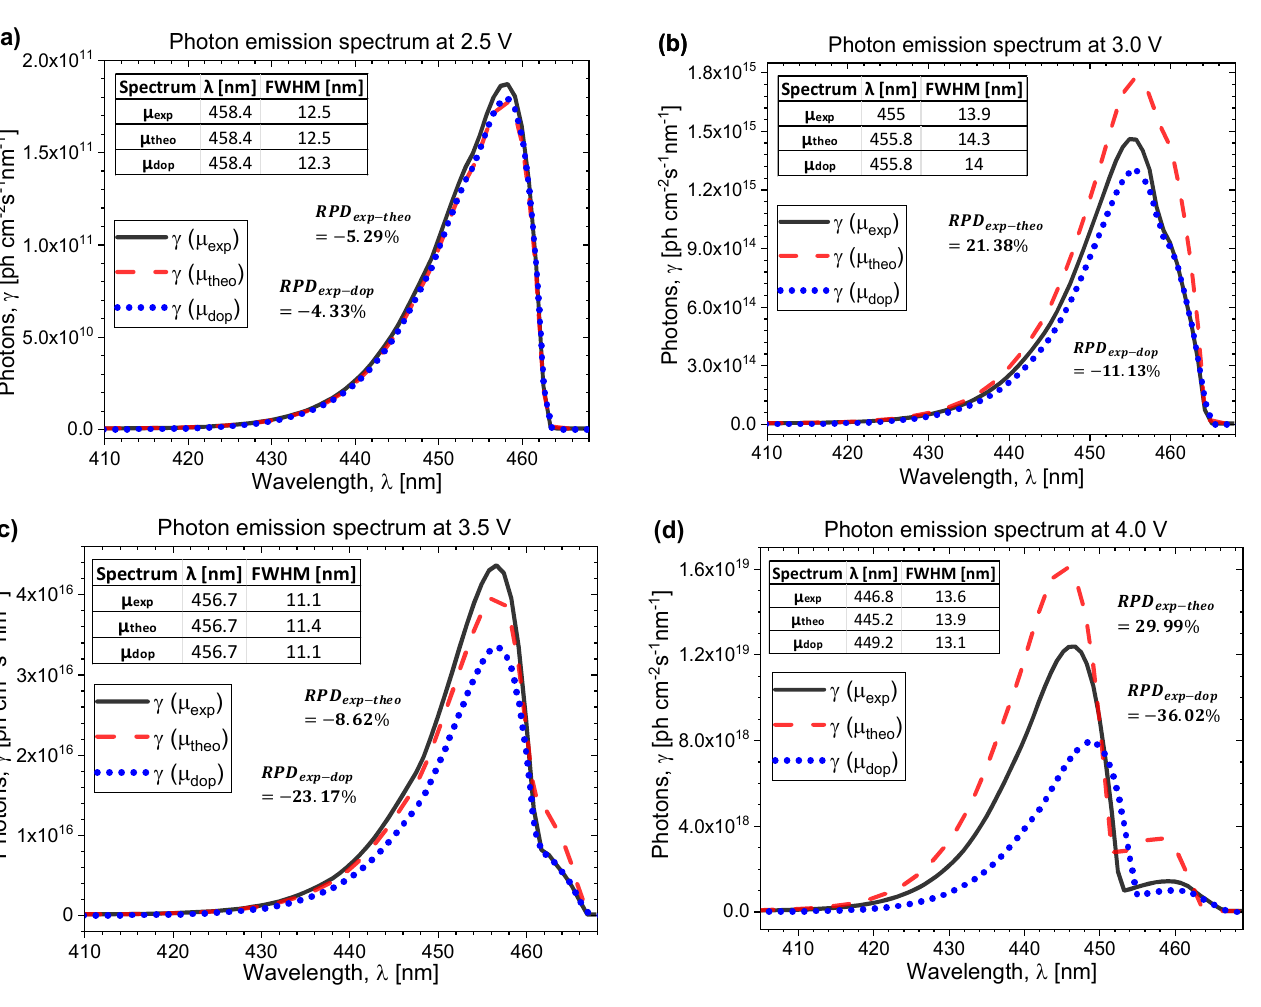
transitions are: e 3 → hh 3 ≈ 2.71 eV ≈ 457.5 nm and e 3 → lh 3 ≈ 2.717 eV ≈ 456 nm.